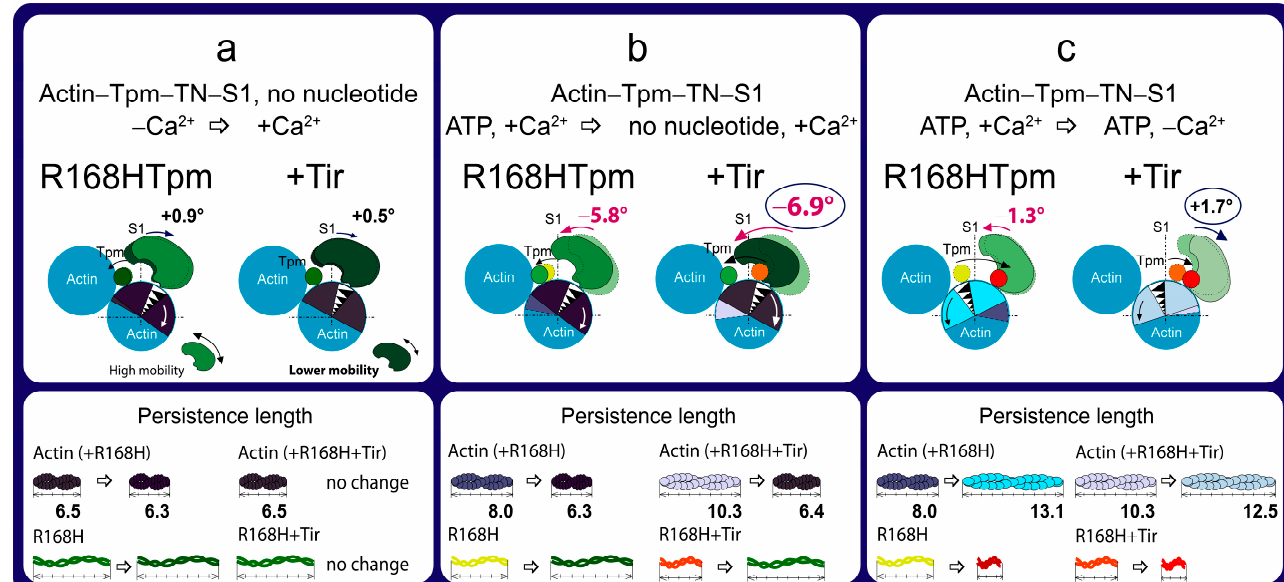
Figure 10. The scheme explains the effect of the fast skeletal troponin activator tirasemtiv (Tir) on the spatial rearrangement of myosin head, the position of the R168H-mutant tropomyosin (Tpm), the angular orientation of actin monomer, and the persistence lengths of the Tpm strands and actin filaments. Three different transitions are shown, influenced by ( a ) an increase in Ca 2+ concentration in the absence of nucleotides, ( b ) a weak-to-strong transition, and ( c ) a decrease in Ca 2+ concentration in the presence of ATP. The R168H substitution prevents the activation of the protein complex in response to an increase in Ca 2+ concentration and inhibits relaxation; tirasemtiv allows activation as well as relaxation. The amplitude of the change in the value of Φ E at the transition between states in the presence of MgATP and in the absence of a nucleotide is increased by Tir. The designations are as in Figure 3.